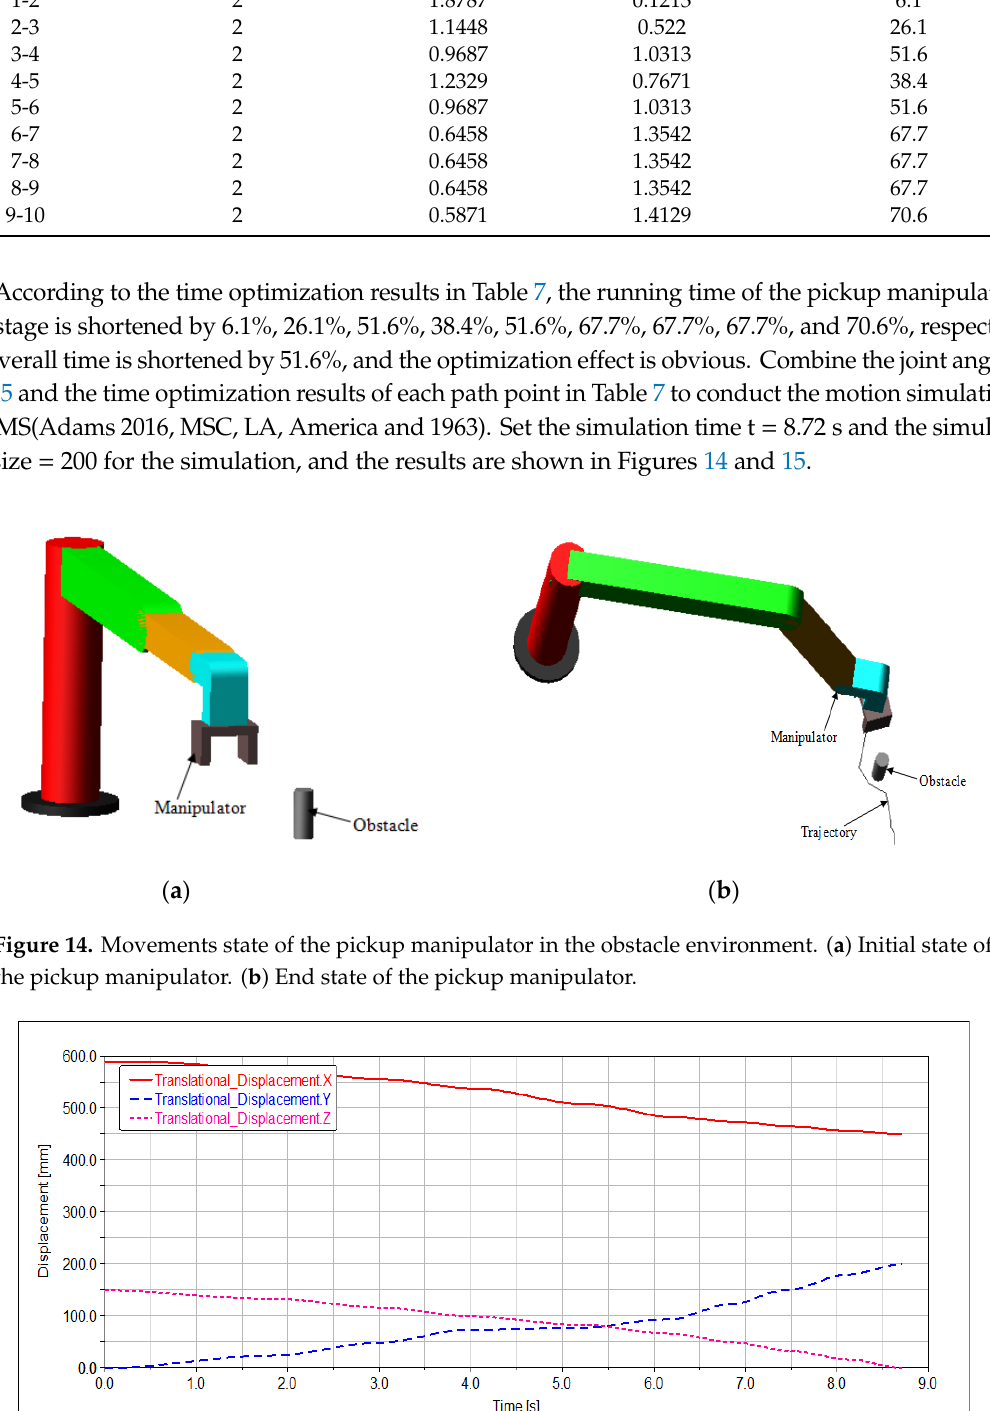
Table 7. Comparison of time optimization results in the obstacle environment.